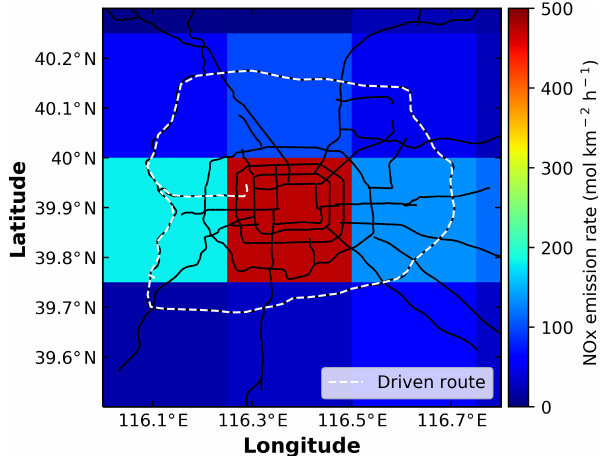
Figure 1. Driving routes (white dashed line) of the car MAX-DOAS experiment on the 6th Ring Rd of Beijing and distribution of yearly averaged NO x emission rate (molkm − 2 h − 1 ) from the MEIC